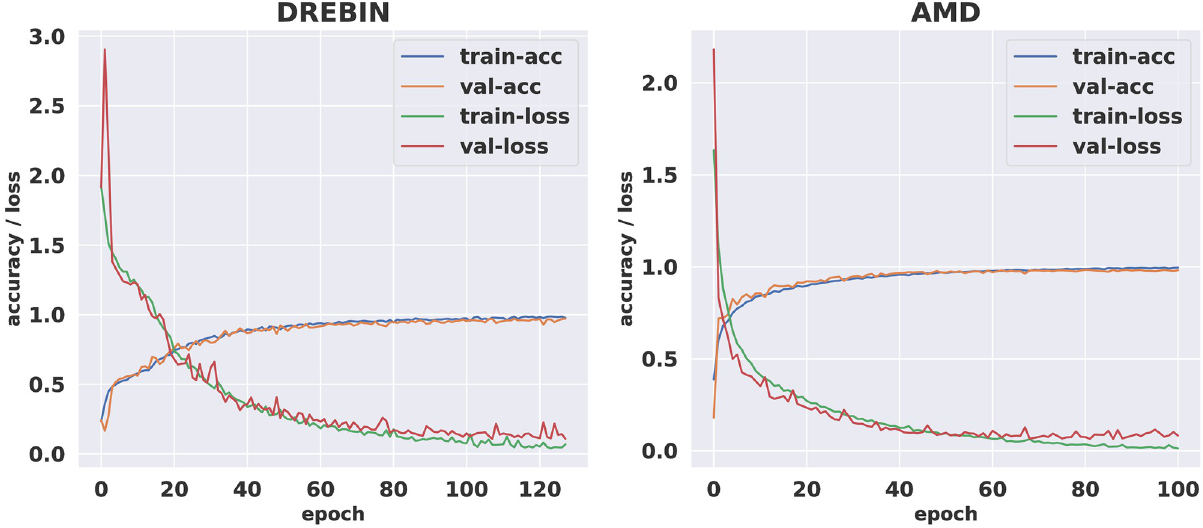
Fig 5. DREBIN VS AMD in terms of best model acc-loss